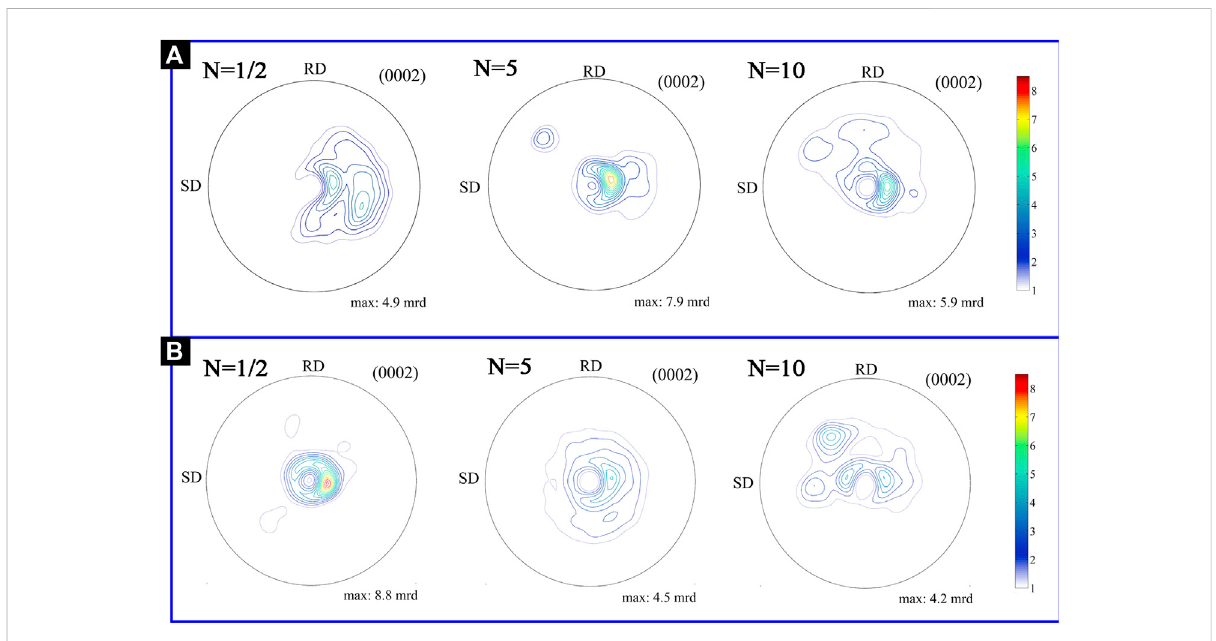
FIGURE 6 The pole fi gures of (A) Mg-1.43Nd alloys and (B) Mg-1.44 Ce alloys (Bourezg et al.,